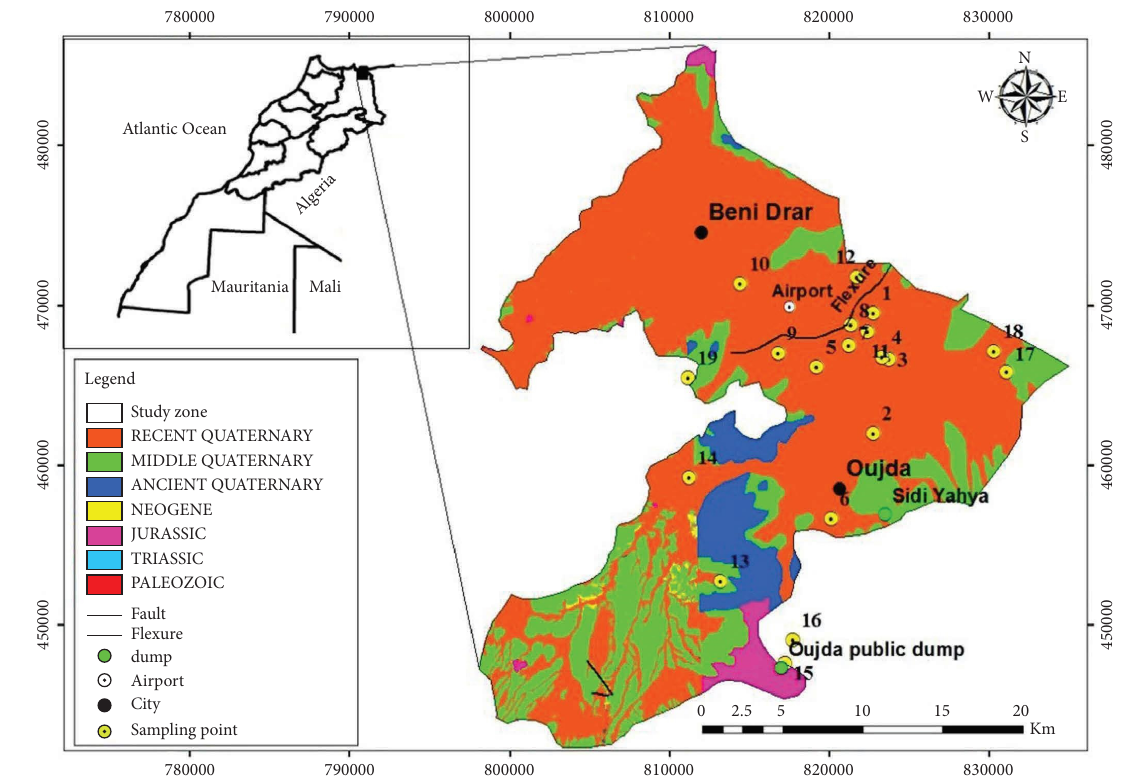
Figure 1: Geological map of the Angads